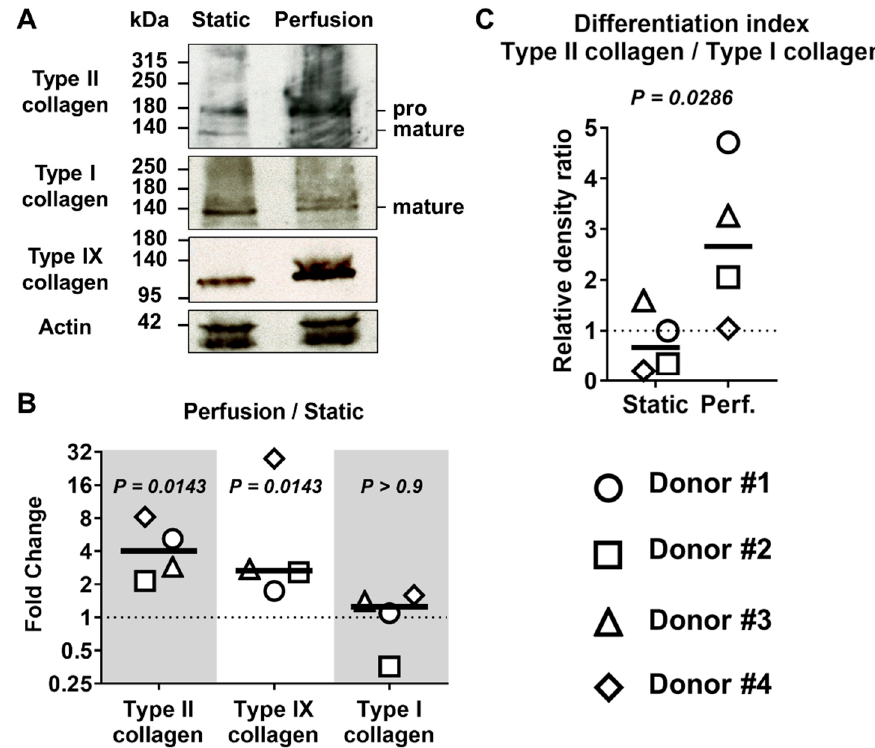
Figure 3. Perfusion promotes the synthesis of hyaline-type of cartilage. ( A ): Representative Western blot (WB) analysis of types I, II, and IX collagens. The positions of mature collagen chains (mature) and unprocessed (pro) are indicated. Actin bands are shown as a control for equivalent loading of the extracts. ( B ): Quantification of type II, type IX and type I collagen through the densitometric analysis of WB data. Total collagens (mature and unprocessed) were normalized to actin and the value of perfusion culture was then divided by the value obtained for the static culture of the same donor. ( C ): Ratio of densitometric values of type II collagen on type I collagen obtained in the same culture and defined as the differentiation index. Symbols in the dot plots represent a single donor data point and the bars represent the median. The level of significance of the statistical analyses ( p -value) is indicated ( n = 4).